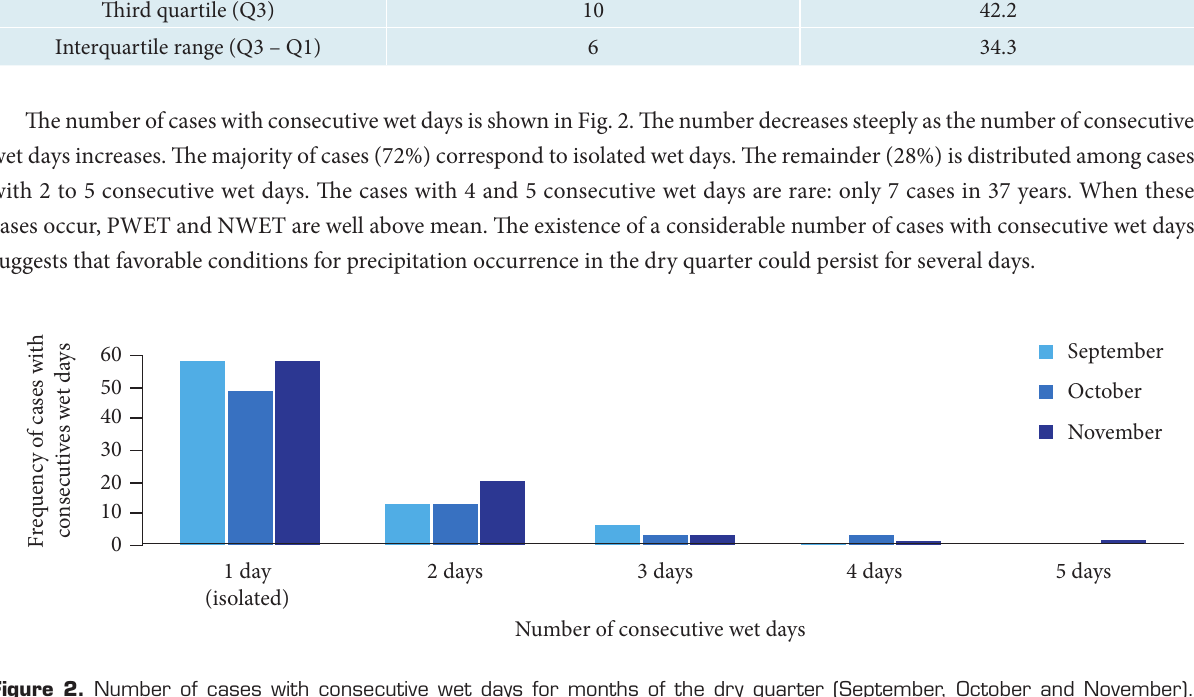
Figure 2. Number of cases with consecutive wet days for months of the dry quarter (September, October and November). Period: 1979-2016, except 2006 (37 years).